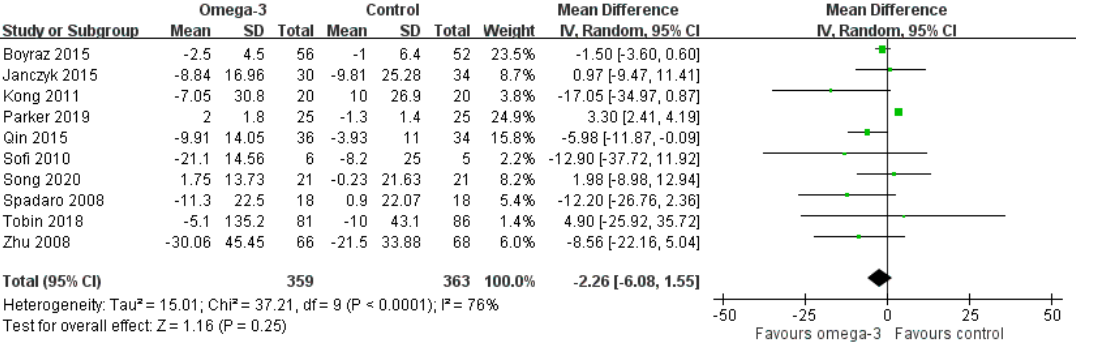
Figure 4. Effect of omega-3 fatty acid supplementation on hepatic enzyme parameters. ( A ) Effect on aspartate aminotransferase. ( B ) Effect on alanine transaminase. ( C ) Effect on gamma glutamyl transpeptidase.